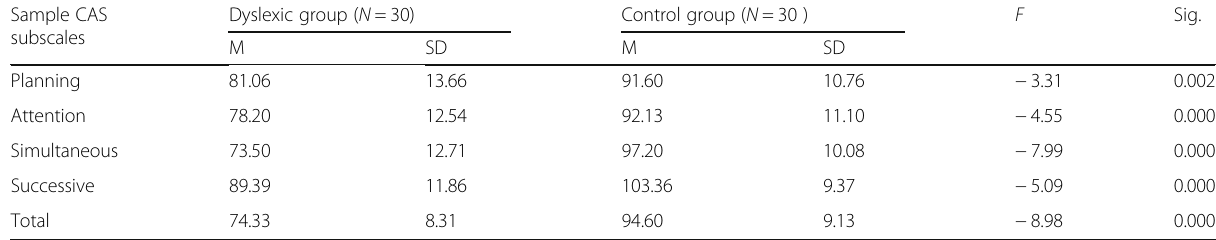
Table 5 Cognitive Assessment System: dyslexic vs. controls (late childhood) Sample CAS Dyslexic group ( N = 30) Control group ( N = 30 ) subscales